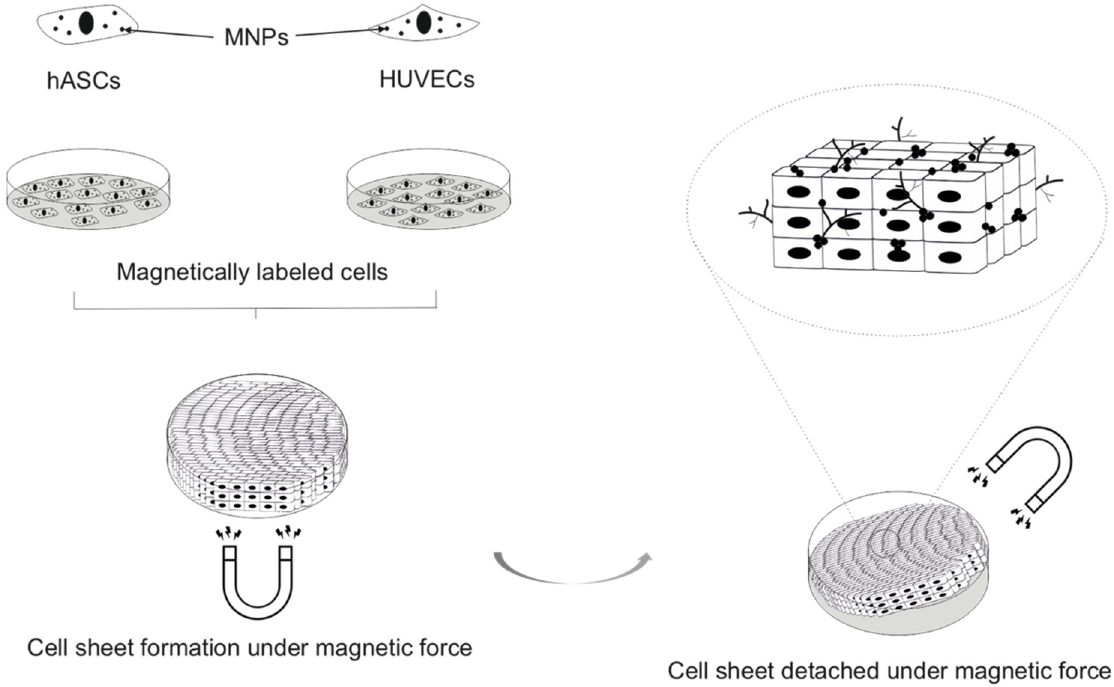
Figure 4. Schematic displaying organisation of MNP-labelled cells into cell sheets and assembly into multilayer constructs in presence of an external magnetic field. multilayer constructs in presence of an external magnetic